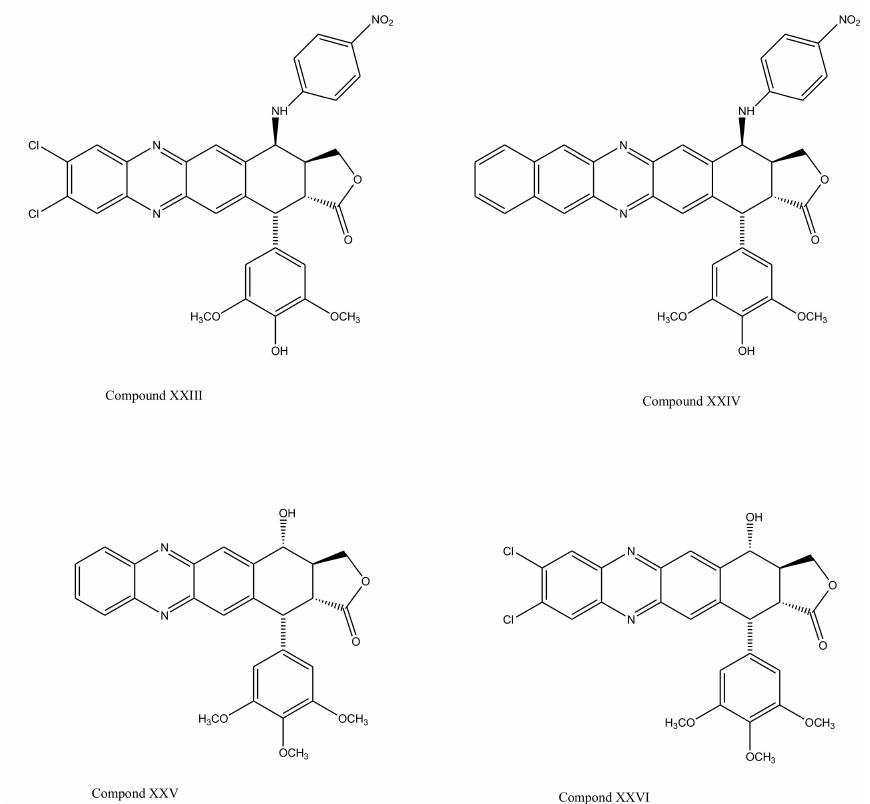
Figure 4. The significance of ring A for biological functionality of podophyllotoxin and its deriva- tives introduced three crucially significant domains in the parent pharmacophore model. Mod- ifying these domains provided a number of new derivatives as shown (Compound XX1–XXVI). These compounds show distinct mechanism of actions in comparison to the previously discovered podophyllotoxin